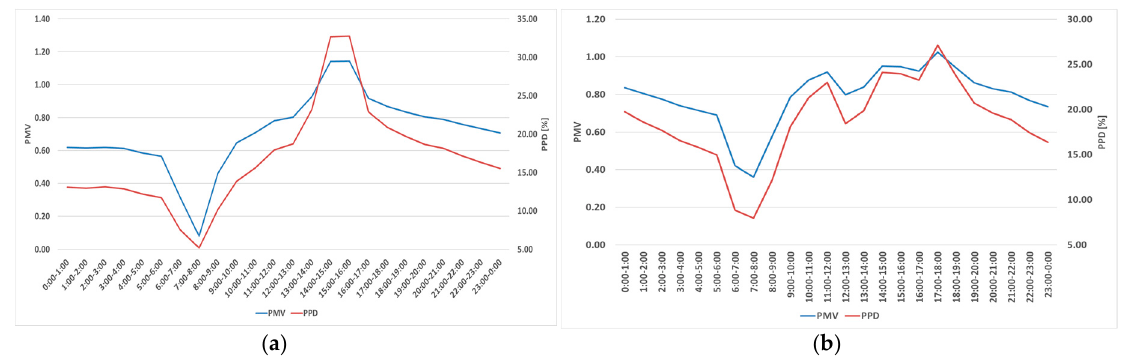
Figure 12. Variation of PMV index in Building B during a typical day in: ( a ) winter (1 March 2016) and ( b ) summer (14 September 2016) along with the respective PPD rates.